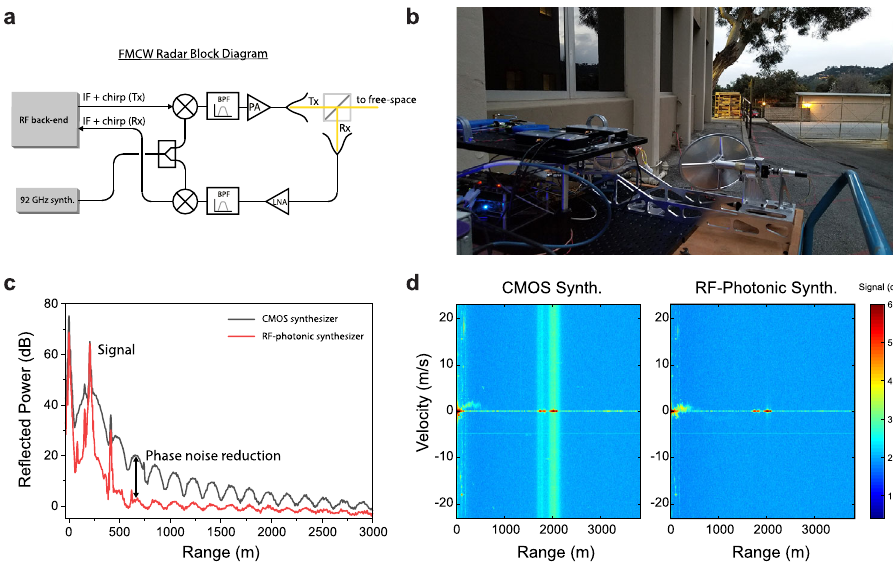
Fig. 3 Field-testing of the heterodyne synthesizer in a 95-GHz continuous-wave radar. a Simpli fi ed block diagram of the frequency-modulated continuous-wave (FMCW) radar. A millimeter-wave source at 92 GHz is mixed with a frequency-chirped modulation waveform around an IF of ~3 GHz. A band-pass fi lter (BPF) rejects un-wanted mixing components, and the signal is ampli fi ed through a W-band power ampli fi er (PA) before being sent to the transmitter optics. Back-re fl ected signals are demultiplexed through polarization duplexing and passed through a low-noise ampli fi er (LNA) and BPF, and are mixed with the 92 GHz source down to the IF, prior to de-modulation and digitization in the back-end electronics. b shows a photograph of the radar test-bench with the primary aperture pointed at a distant hill, with the heterodyne synthesizer breadboard mounted on top. c plots measured back- re fl ection data from a building ~207 m away, when using either the radar ’ s existing 92 GHz CMOS synthesizer (dark gray) or the microwave-photonic heterodyne synthesizer (red). Phase noise fringes are signi fi cantly suppressed when using the low-noise photonics-based source. d plots Doppler data when the radar is pointed at a distant hill as in ( b ). Weak signals from drizzle are visible as slow-moving signatures at ranges closer than 1 km. When using the relatively noisy CMOS synthesizer (left), bright re fl ections from stationary hills lead to strong Doppler artifacts that would obscure the observation of co-located moving objects. By contrast, when using the heterodyne synthesizer (right), these artifacts are practically